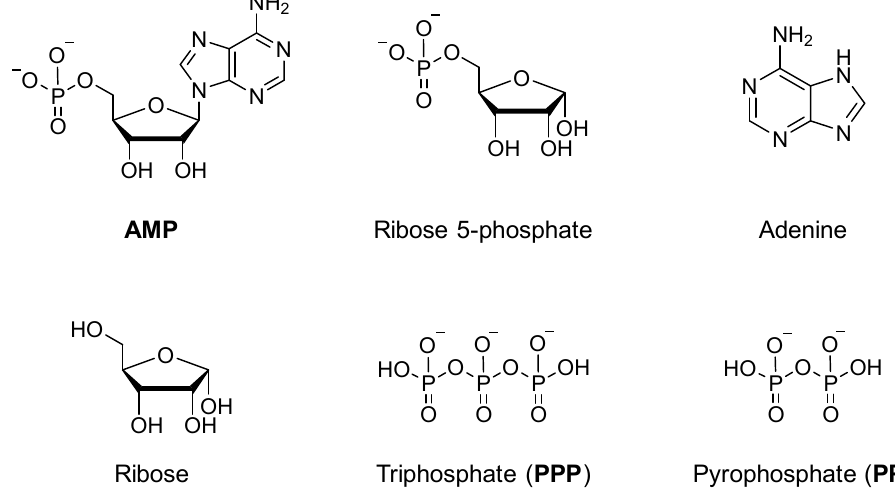
Figure 6. Molecular structure of molecules structurally related to ATP. Inspection of the 51 V-NMR spectra recorded before and immediately after the mixing of PP and PPP with vanadate revealed the presence of a new resonance around − 540 ppm (Figure 7). This peak agrees well with the formation of cyclic bidentate and tridentate dian- hydrides between vanadate and polyphosphate species reported previously [28,29]. The resonance at − 540 ppm was more intense in the case of PP than in the case of PPP. Further, monitoring the PP and PPP solutions with decavanadate for possible phosphoanhydride hydrolysis over several days revealed the relatively fast hydrolysis of PPP to PP, which in turn slowly hydrolyzed to inorganic phosphate. Upon complete PPP hydrolysis to PP, the resonance at − 540 ppm became more intense. Accordingly, PP was also slowly converted to inorganic phosphate in the presence of decavanadate. AMP, ribose 5-phosphate, ribose and adenine did not alter the 51 V-NMR spectra of decavanadate, suggesting that no significant interaction between these components and vanadates took place in the solution. No changes or hydrolysis were observed in both 51 V- and 31 P-NMR spectra upon mixing AMP and vanadate, even though broadened 31 P resonances were observed for ribose 5-phosphate (Figure S13). No hydrolysis of the phosphoester bond in ribose phosphate was detected. Moreover, no evidence of ribose– vanadate interactions was detected by 51 V-NMR for AMP, ribose 5-phosphate or only ribose, even though an interaction between monomeric vanadate and the 2,3-hydroxyl groups of ribose is described in the literature [32–34]. The 51 V resonance expected for this type of complex appears at − 520 ppm, and, therefore, it is also plausible that it overlaps with one of the V 10 resonances. Finally, no changes in the 1 H-NMR spectra of ribose and adenine could be detected, even after keeping the reaction mixture for several days, implying that decavanadate does not interact with these